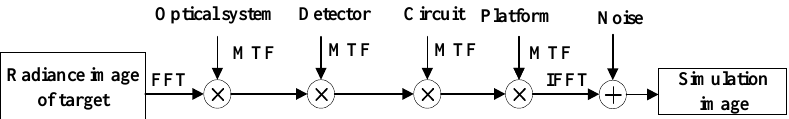
Figure 12. Mathematical model of the radiative transfer process.